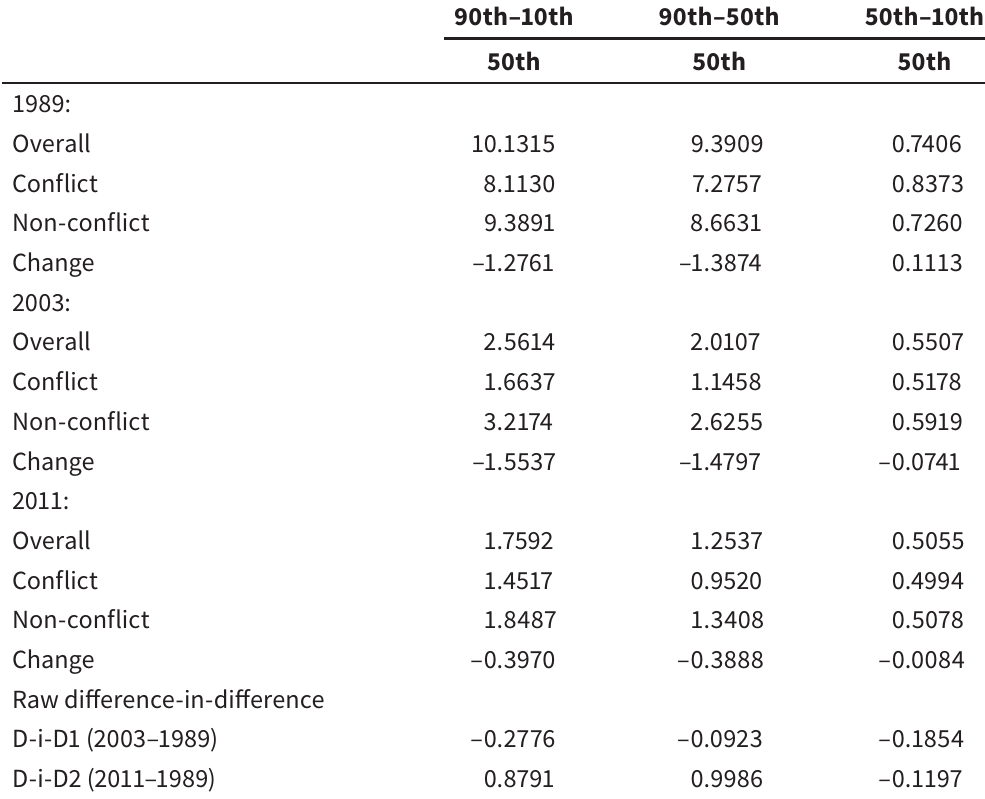
Sierra Leone Household Expenditure Percentile Ratios by Conflict